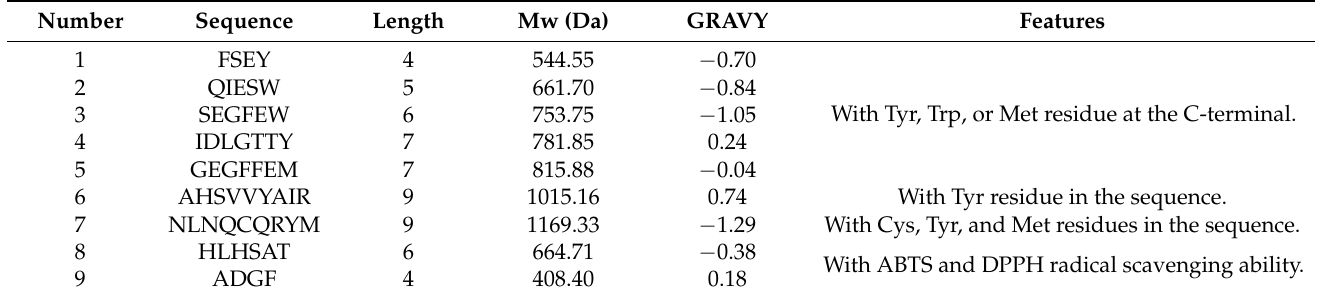
Table 2. Sequences of synthetic peptides containing Tyr, Trp, Cys, and Met